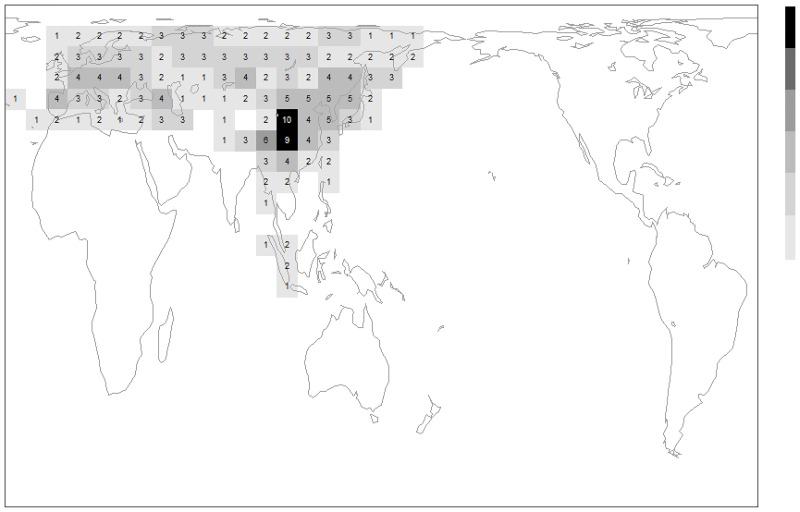
Distribution of diversity for the subgenus Megabombus among equal-area grid cells.Data for China are updated from the review by Williams 1998 using the IAB collection, and exclude records for known introductions (New Zealand, South America, Iceland). The grid is based on longitudinal intervals of 10°, which are used to calculate graduated latitudinal intervals to provide equal-area cells (each cell of area approximately 611,000 km²). Grey scale (right) with equal-interval richness classes. Cylindrical orthomorphic projection (excluding Antarctica) with north at the top of the map.